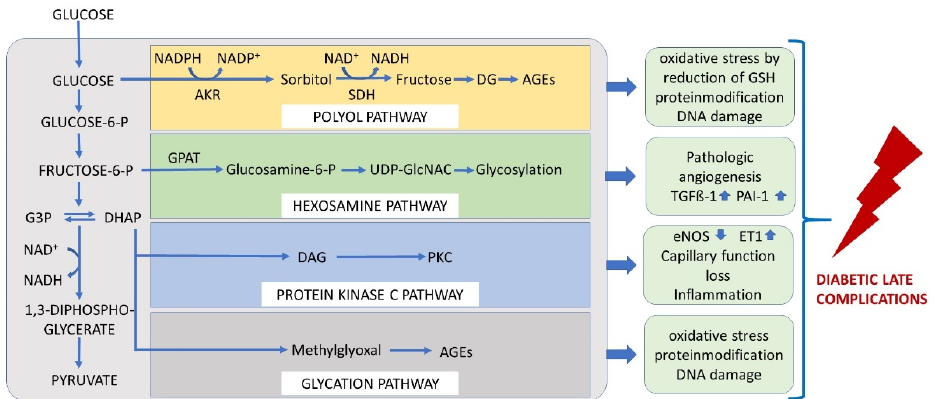
Figure 3. The unifying hypothesis comprises mechanisms by which glucose at each level of glycolysis contributes to the generation of late diabetic complications. Under physiological conditions, glucose is metabolised through the glycolytic pathway. Increase in intracellular glucose leads to increased flux of glucose to sorbitol via the polyol pathway, to an increase in the hexosamine pathway, to activation of protein kinase C (PKC), and to formation of advanced glycation end products (AGEs) in endothelial cells. AKR = aldose reductase, SDH = sorbitol dehydrogenase, GFAT = glutamine: fructose-6-phosphate amidotransferase, GlcNAc = N-Acetylglucosamin, DAG = diaclyglycerol, PKC = proteinkinase C, G3P = glyceraldehyd 3-phosphate, DHAP = dihydroxyacetone phosphate.